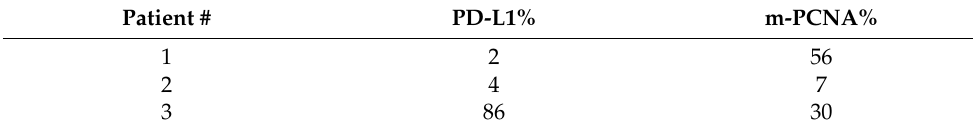
Table 1. Extent of PD-L1 and m-PCNA staining in cells from all three patients.